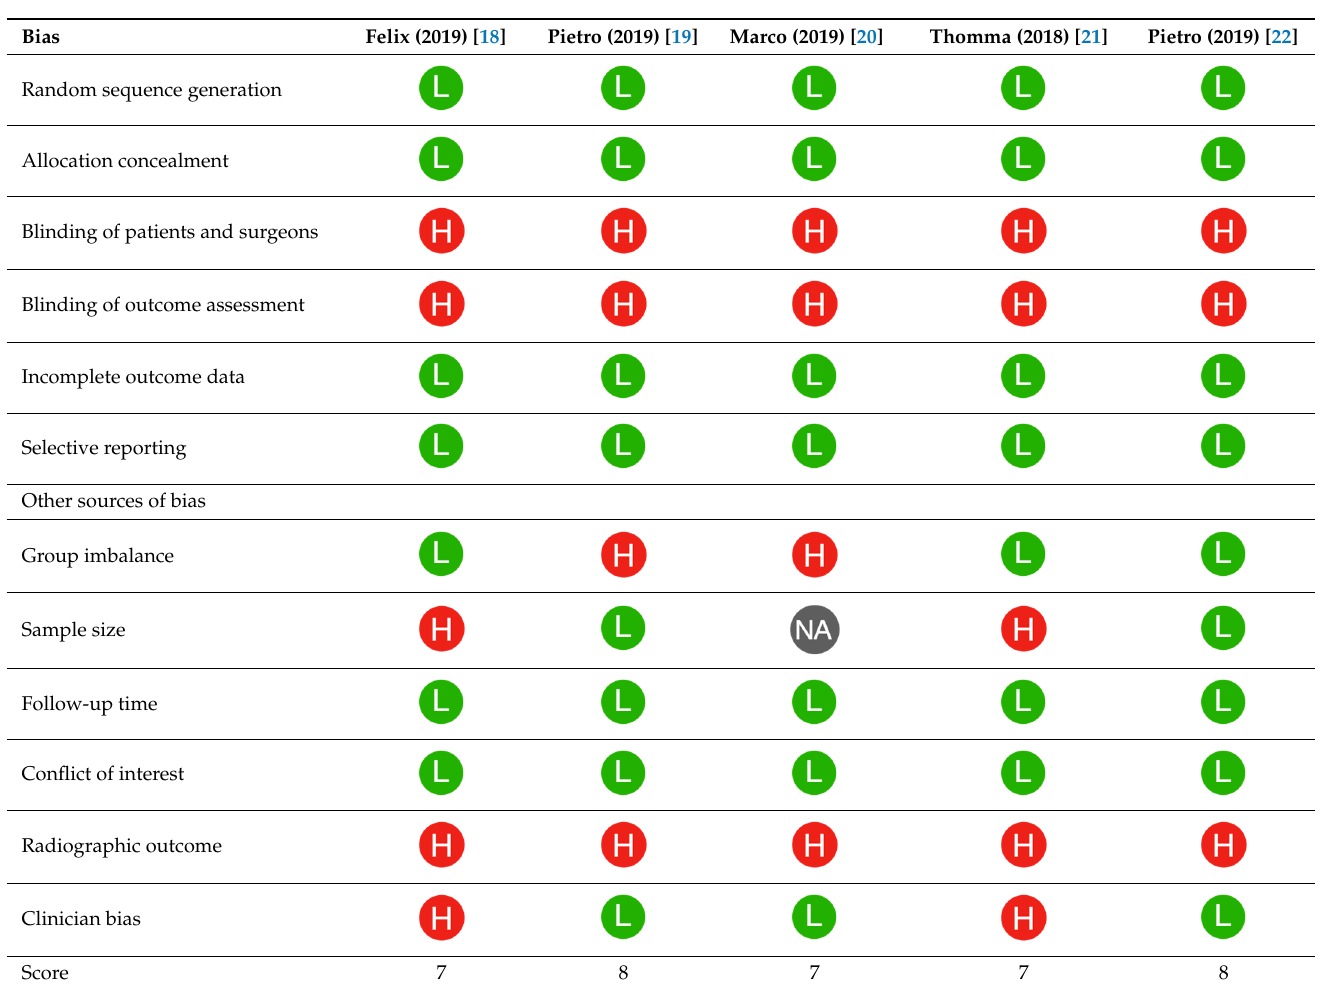
Table 3. Quality assessment of included studies.